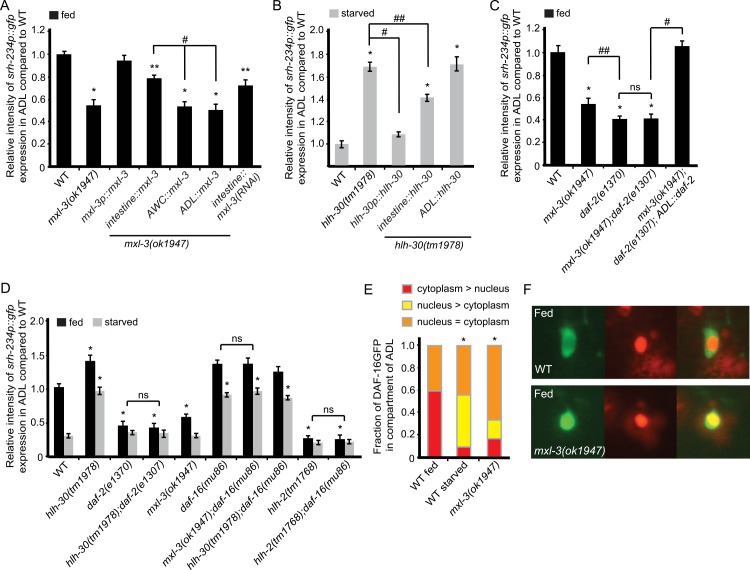
Intestinal mxl-3 and hlh-30 expression regulates srh-234 in ADL neurons, which is dependent on daf-2/daf-16 insulin signaling.(A, B) Selective expression of mxl-3 and hlh-30 in the intestine is partly sufficient to regulate srh-234 expression in ADL. Shown is the relative expression of srh-234p::gfp in the ADL cell body of adult mxl-3
(A) or hlh-30 mutants (B) compared to wild-type adult animals when well-fed (A) and starved (B), respectively. (C) Selective expression of the daf-2 insulin-like receptor in ADL suppresses the reduced srh-234 phenotype of adult mxl-3; daf-2 double mutants. Shown is the relative expression of srh-234p::gfp in adult single and double mutants of mxl-3 and daf-2 compared to wild-type adults during well-fed conditions. daf-2(e1307) is a temperature sensitive allele. For these experiments, animals were raised at 15°C (permissive temperature) and shifted to the 25°C (restrictive temperature) as L4-staged larvae. (D) Mutations in daf-2 and daf-16 suppress the srh-234 expression phenotypes of hlh-30 and mxl-3 mutants, respectively, whereas hlh-2 suppresses daf-16 in regulating the expression of srh-234. Shown is the relative expression of srh-234p::gfp in the ADL cell body in adult single and double mutants of hlh-30, daf-2 or daf-16 compared to wild-type adults in well-fed and starved conditions with >25 adult animals for each genotype. (A-D) data shown is the average of at least two independent transgenic lines with n>25 adult animals for each line. * and ** indicates values that are different from that of wild-type adult animals at P<0.001 and P<0.01, respectively, and # and ## between the genotypes compared by brackets at P<0.01 and P<0.05, respectively. Error bars denote the SEM. (E, F) Quantification (E) and representative images (F) of subcellular localization of DAF-16::GFP in ADL neurons of adult wild-type and mxl-3 mutants in either fed or starved conditions. n>20 adult animals for each genotype and condition. * indicates values that are different from fed wild-type distribution at P<0.001 as determined by the χ2 test.